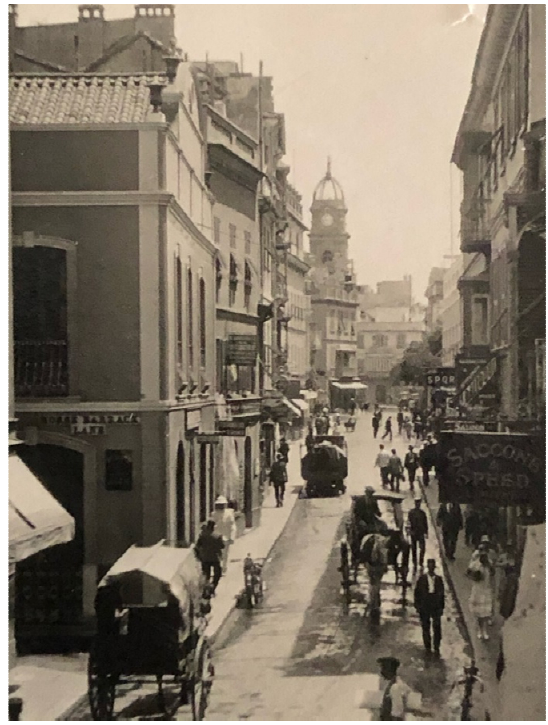
Figure 6. Detail of Figure 4. The building on the left before the carriage is 153 Main Street, the site of the Church of la Vera Cruz.